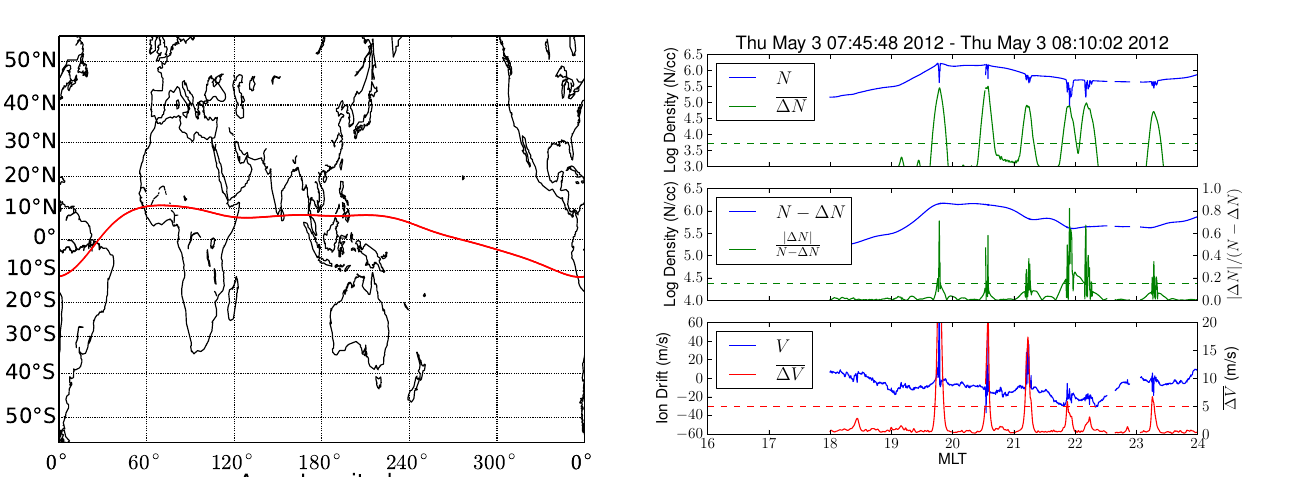
Fig. 2. CINDI measurements of top: ion density and associated vari- ance middle: estimated background ionosphere and the absolute magnitude of the wavelet-derived density perturbations waveform bottom: measurements of meridional ion drift along with its scale- limited variance. A portion of a single orbit is shown.